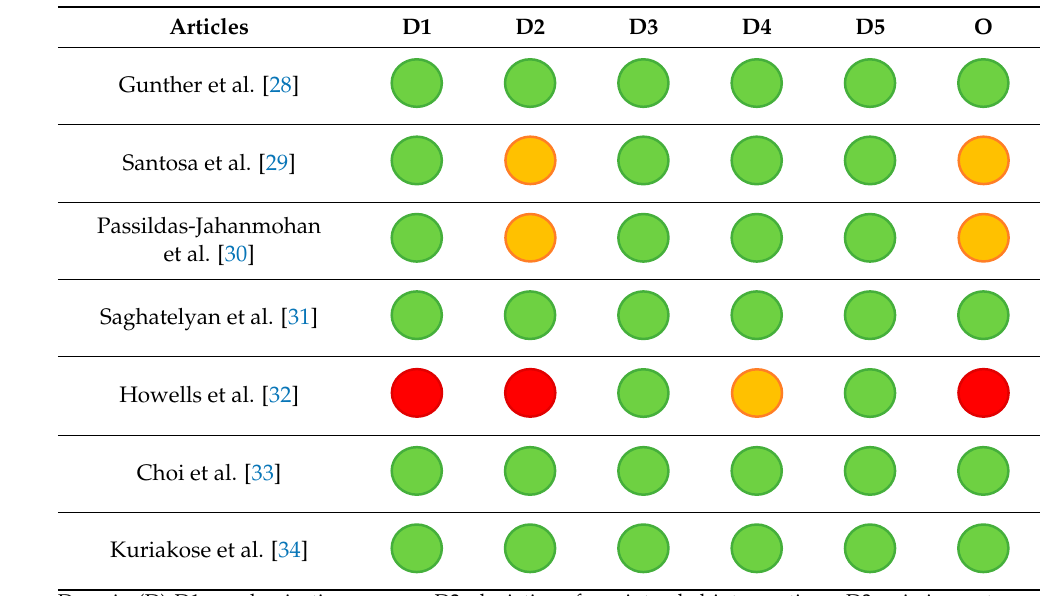
outcome data; D4, measurement of the outcome; D5, selection of the reported results; O, overall evaluation (for further information, see the Section 2). Red circles: high risk; green circles: low risk; yellow circles: some concerns.